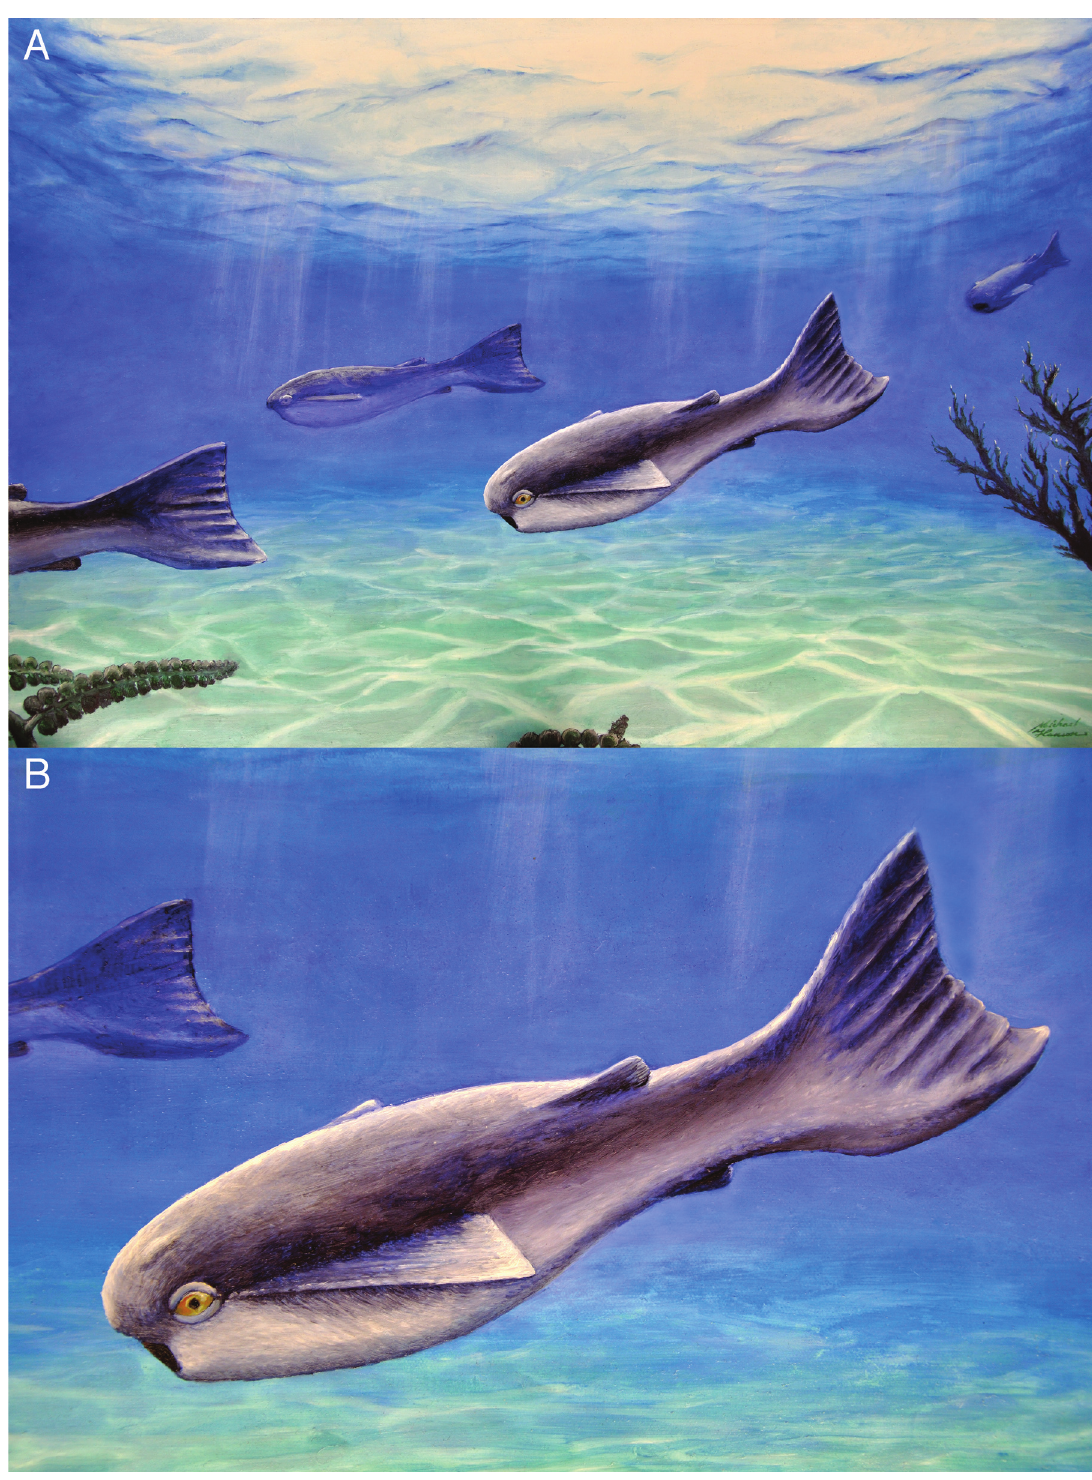
Fig. 9. Artists conception of the Silurian thelodont Phlebolepis elegans Pander preserved in a mass-mortality layer in the carbonate-rich sedimentary rocks at Himmiste-Kuigu, Saaremaa, Estonia. A , members of the school swimming in a lagoon prior to suffering the mass mortality event. B , closeup of the foreground individual of Phlebolepis elegans Pander to illustrate revised concepts of its external morphology. Artwork for A and B by Michael Hanson,